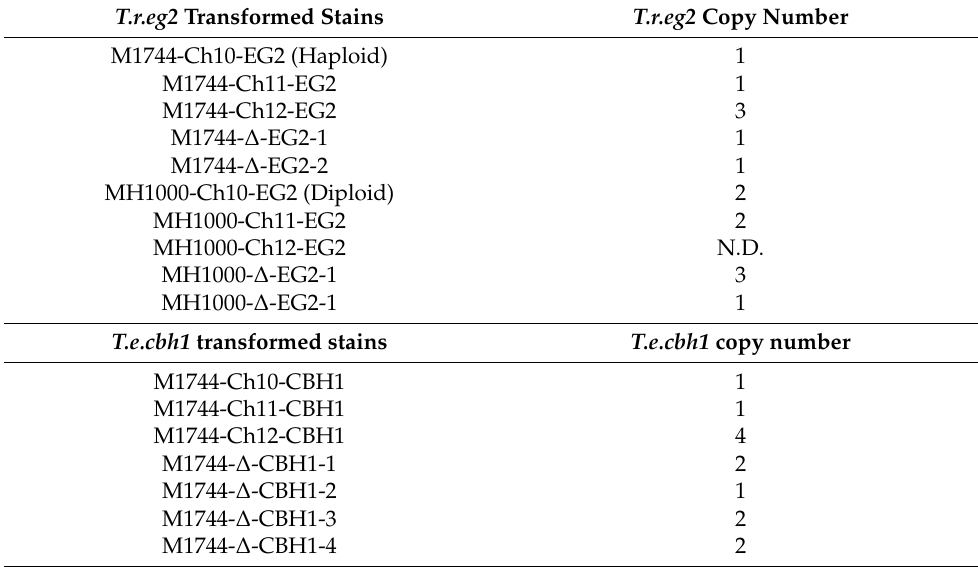
Table 3. Copy numbers of heterologous cellulase genes integrated at different chromosomal sites in the various transformants. Numbers after the strain names indicate different transformants of the same strain that were tested and match the numbers indicated in Figures 3 and